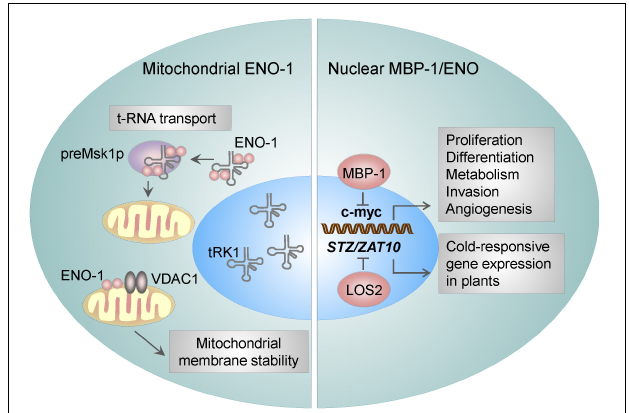
FIGURE 2 | ENO-1 activities in the nucleus and mitochondria. Mitochondria bound ENO-1 acts as a RNA chaperone by binding to and transporting nucleo-cytoplasmic tRNAs to the mitochondria. Furthermore, by binding to the VDAC1 (an integral mitochondrial membrane protein), ENO-1 participates in the stabilization of the mitochondrial membrane potential. By using an alternative start codon, ENO-1 gene can give rise to truncated 37 kDa protein – myc promoter-binding protein 1 (MBP-1), which suppresses the activity of c-myc transcription factor and thereby regulates proliferation and invasion of cancer cells. ENO in plants is encoded by LOS2 , which binds to the promoter of the STZ/ZAT10 gene, that possesses the cold- and osmotic stress-responsive